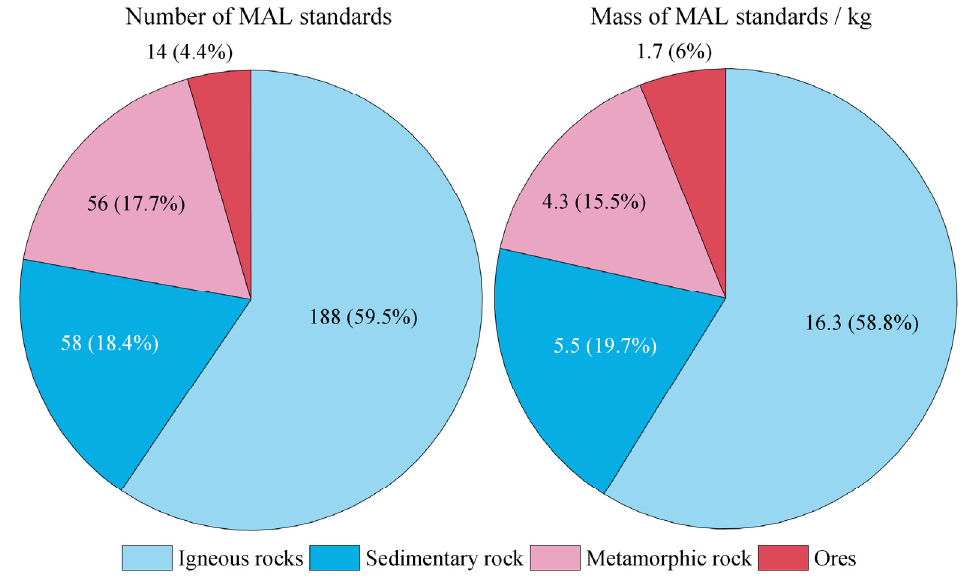
Figure 2. Pie graph of number and mass (kg) of MAL standards.